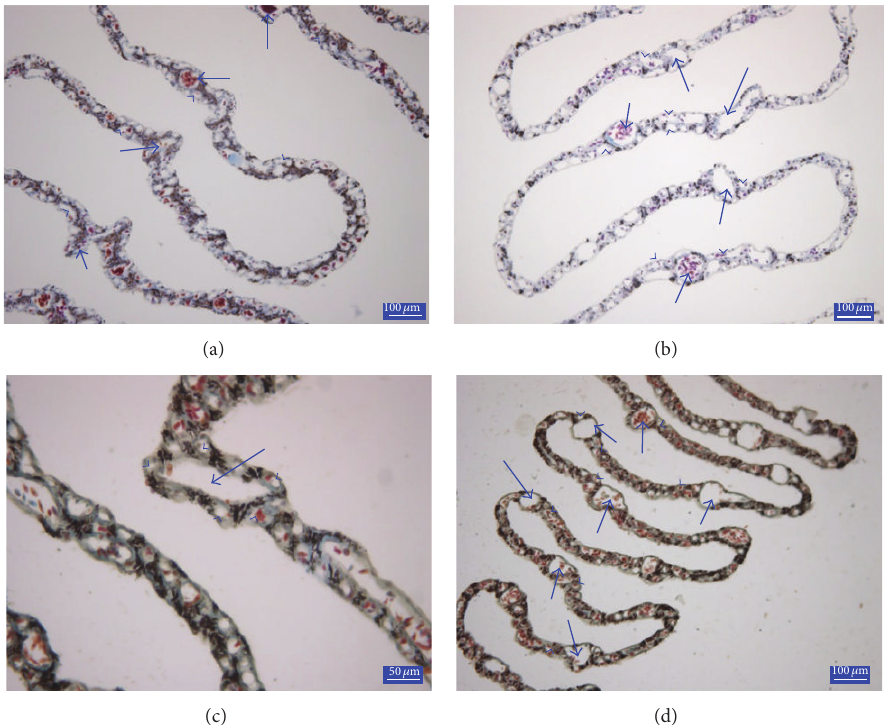
Figure 4: A section from the duck pecten oculi (a); a section from the pigeon pecten oculi (b); a section from the turkey pecten oculi (c); a section from the starling pecten oculi (d); arrows: blood vessels, arrow heads: blood capillaries. Crossmon’s trichrome